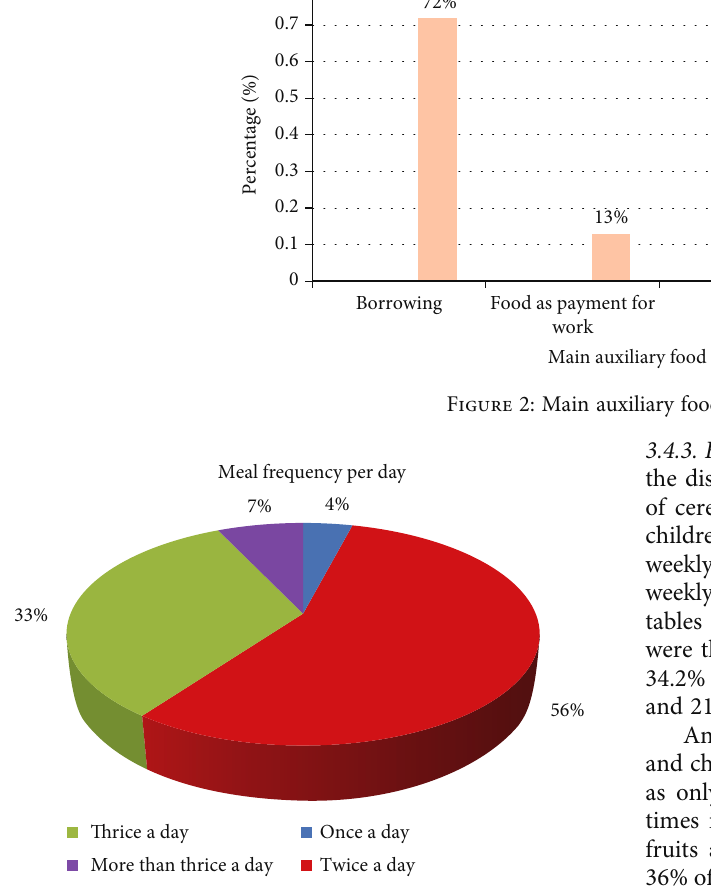
Figure 3: Number of eating times in a